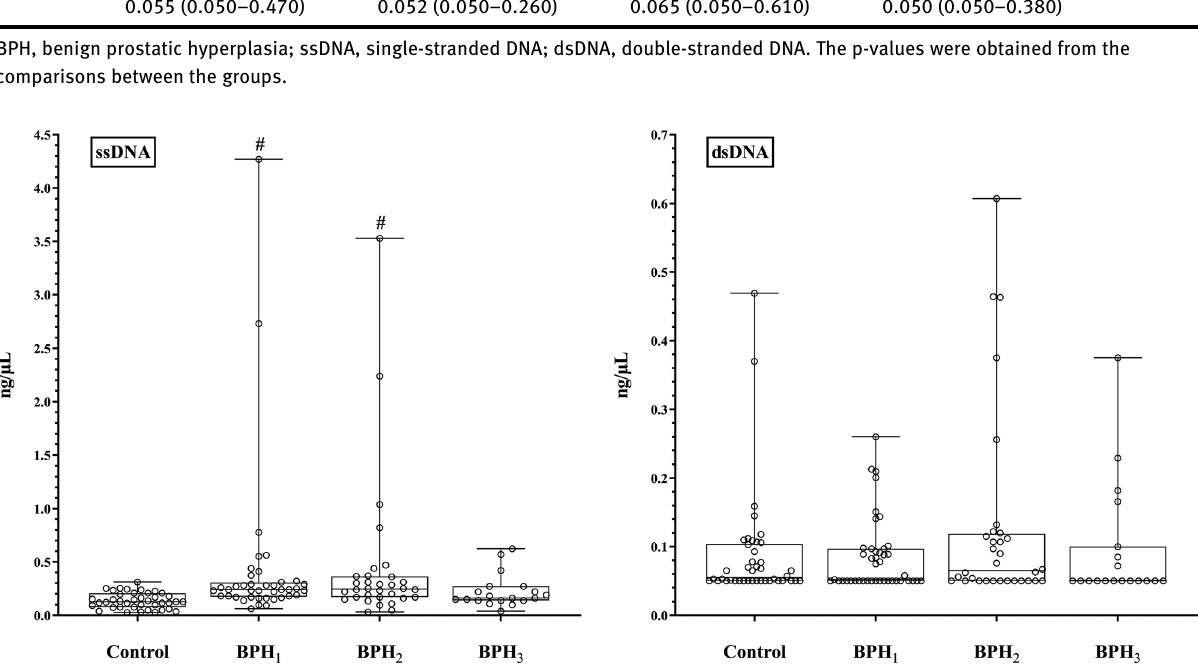
Figure 1: Graphical comparison of the ssDNA amounts in the control, preoperative (BPH 1 ) and postoperative (BPH 2 and BPH 3 ) samples of the patients. #: statistically signi fi cant increase compared with the control group (p<0.001).